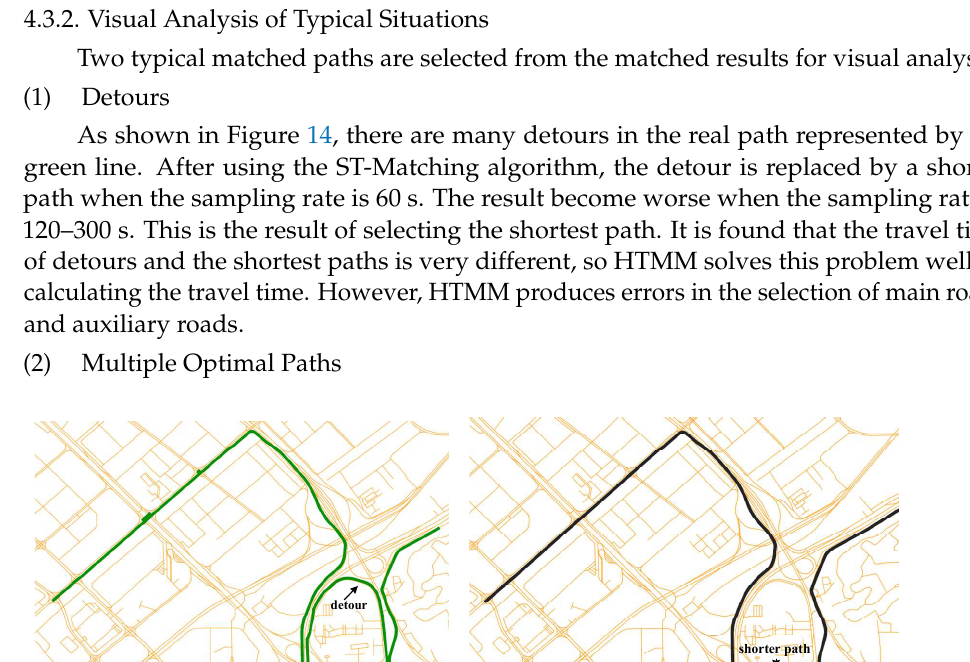
Figure 13. Matching time of three algorithms at different sampling rates.